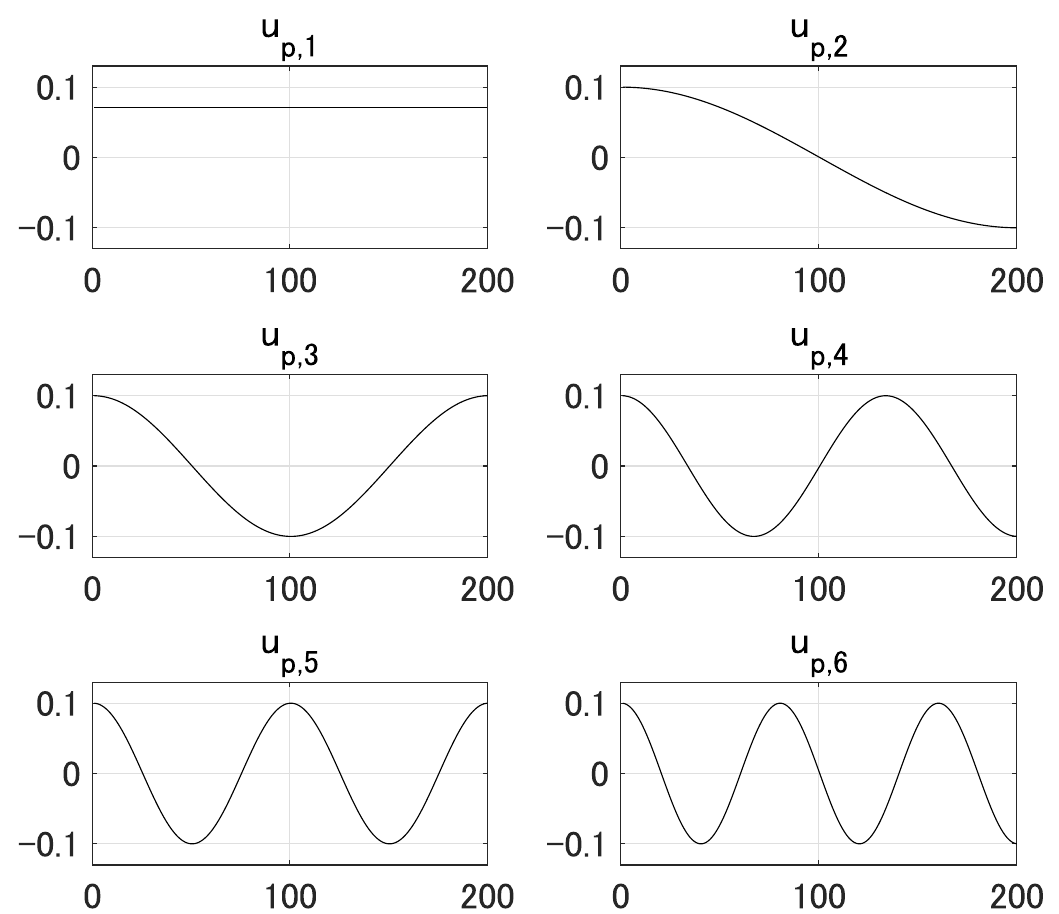
Figure A3. The first six columns of U p = [ u p ,1 , . . . , u p , n ] in (A20) for n =